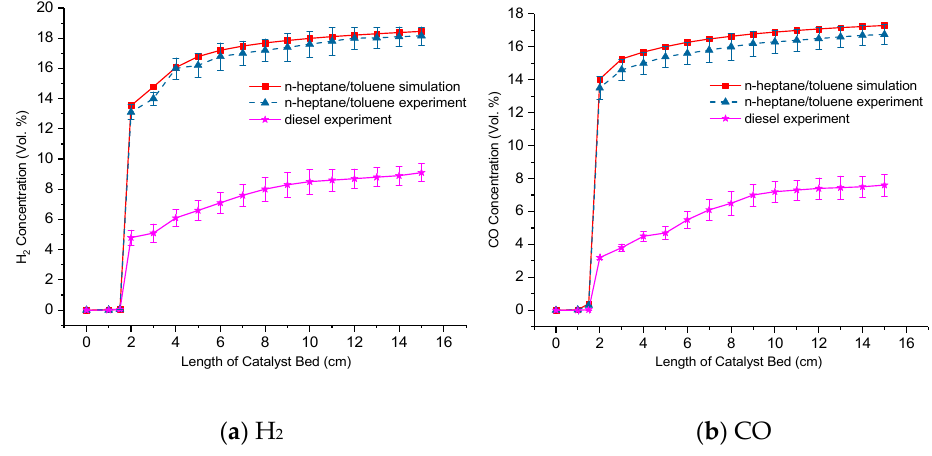
Figure 12. H 2 and CO concentration comparison and Error bars analysis.